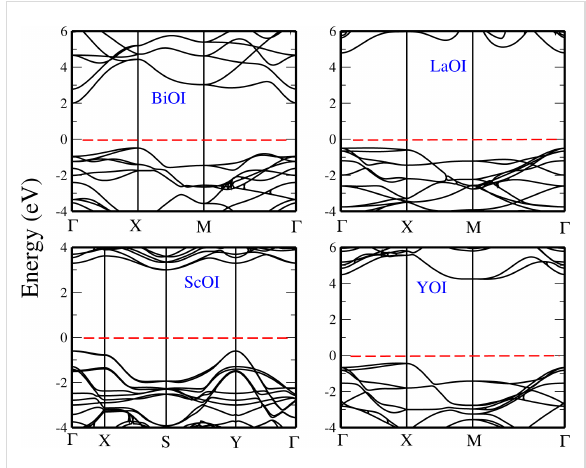
GGA and 4.80 eV with HSE. BaFCl is found to be a direct-gap semiconductor with the valence-band maximum and the conduction-band minimum at the Γ